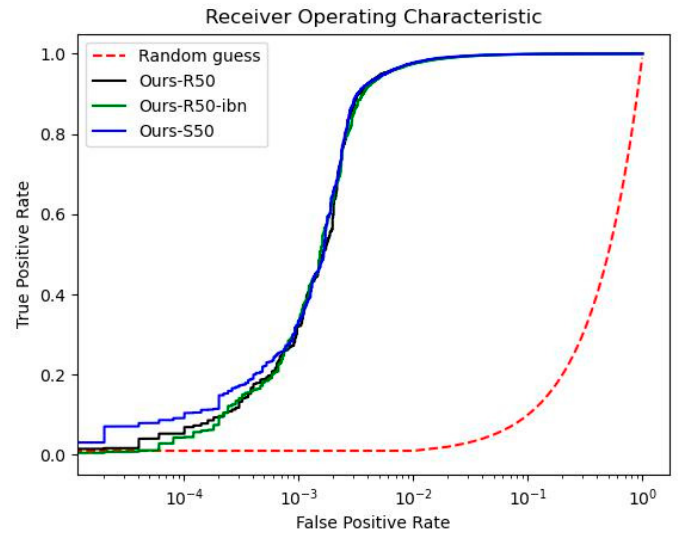
Figure 5. ROC curve with the horizontal axis on a logarithmic scale on Market1501 dataset.